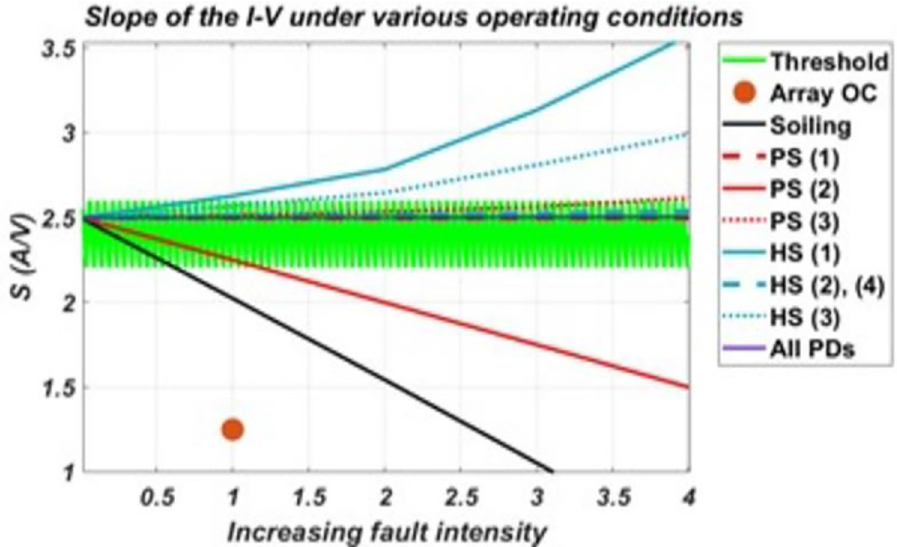
Fig 8. Response of S (slope) to various conditions and their varied intensity